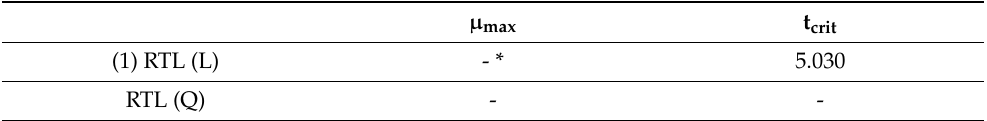
Table 2. Standardized effects of linear (L), quadratic (Q), and interactive terms of RLT (relative lag time), temperature, concentration of NaCl, liquid smoke, and the amount of nitrite and CO 2 at equilibrium in the headspace on the maximal growth rate ( µ max ) and time to attain the steady state (t crit ) of lactic acid bacteria in fish products. The standardized effect was evaluated as the ratio of the mathematical coefficient of each factor (from multiple regression) vs. its standard error. The degrees of freedom for the t -test were 204; R 2 ad , regression coefficient corrected for multiple regression. * Not